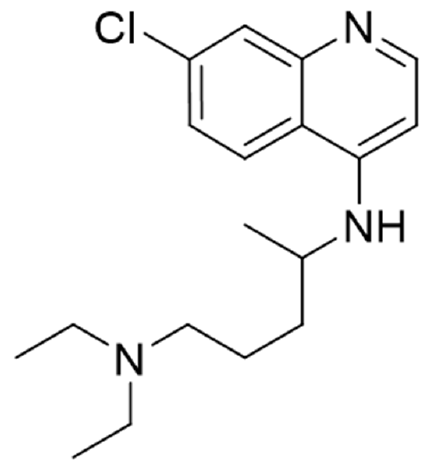
Figure 17. The molecular structure of Chloroquine ® [43].